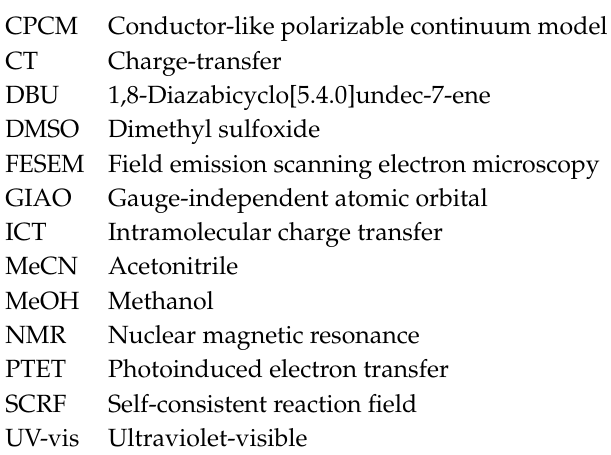
room temperature under aerobic conditions. Figure S7: Normalized excitation and emission spectra of 3 (0.01 mM) in dichloromethane, acetonitrile, methanol and dimethylsulfoxide at room temperature under aerobic conditions. Figure S8: Absorption spectra of 3 (0.01 mM) in dichloromethane, acetonitrile, methanol and dimethylsulfoxide at room temperature under aerobic conditions. Figure S9: Normalized excitation and emission spectra of 3 (0.01 mM) in dichloromethane, acetonitrile, methanol and dimethylsulfoxide at room temperature under aerobic conditions. Table S1: Photophysical data of sensor 2 ( c = 10 ´ 5 M). Table S2: Photophysical data of sensor 3 ( c = 10 ´ 5 M). Table S3: Photophysical data of sensor 4 ( c = 10 ´ 5 M). Figure S10: Absorption spectra of 1 ( c = 0.04 mM) in the absence and with increasing amounts of Cl¯, Br¯ and I¯ ( c = 0, 0.03 mM Ñ 1 mM) in acetonitrile at room temperature. Figure S11: Emission spectra of 1 (0.04 mM) in the presence of increasing amounts of chloride ( λ exc = 252 nm), bromide ( λ exc = 252 nm) and iodide ( λ exc = 300 nm) in acetonitrile. Figure S12: Emission spectra of 1 ( c = 0.04 mM, λ exc = 252 nm) in the presence of increasing amounts of a mixture of halide anions ( c = 0, 0.004 mM Ñ 0.48 mM) in acetonitrile. Figure S13: Emission spectra of 1 ( c = 0.04 mM, λ exc = 252 nm) in the presence of increasing amounts of fluoride ( c = 0, 0.004 mM Ñ 0.02 mM) in acetonitrile. Figure S14: Changes in the maximum emission of sensors 2 – 4 upon titration with different halides in acetonitrile at room temperature. Figure S15: Changes in the emission of 1 ( c = 0.04 mM, λ exc = 252 nm) at 332 nm upon titration with different anions in acetonitrile. Figure S16: Stern-Volmer plots for the fluorescence of 1 ( c = 0.04 mM, λ exc = 252 nm) upon fluoride ( (cid:4) ) and DBU ( ) titration ( c = 0, 0.004 mM Ñ 0.32 mM) in acetonitrile. Figure S17: Changes in the 1 H-NMR (400 MHz) spectra in CD 3 CN. A: sensor 1 (0.02 mmol); B: sensor 1 + 0.75 eq. of fluoride; C: sensor 1 + 0.75 eq. of fluoride + one